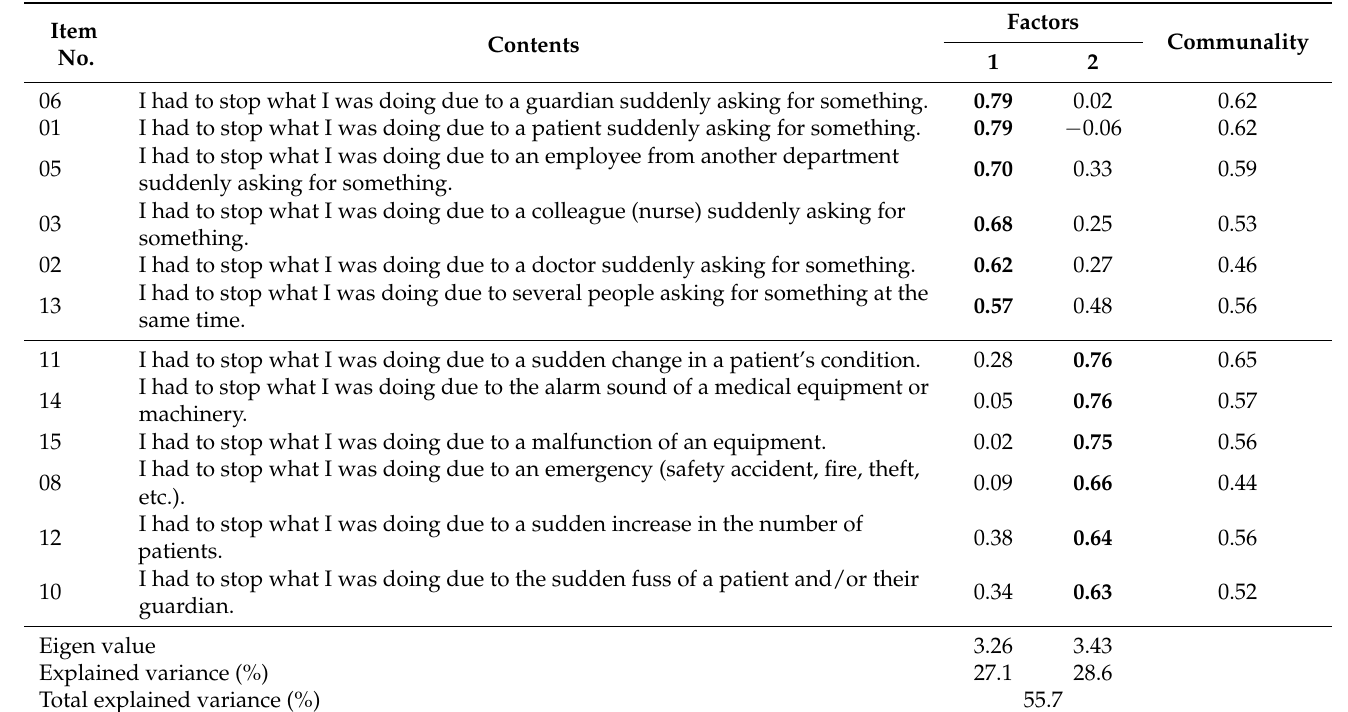
Table 2. Exploratory factor analysis (N =